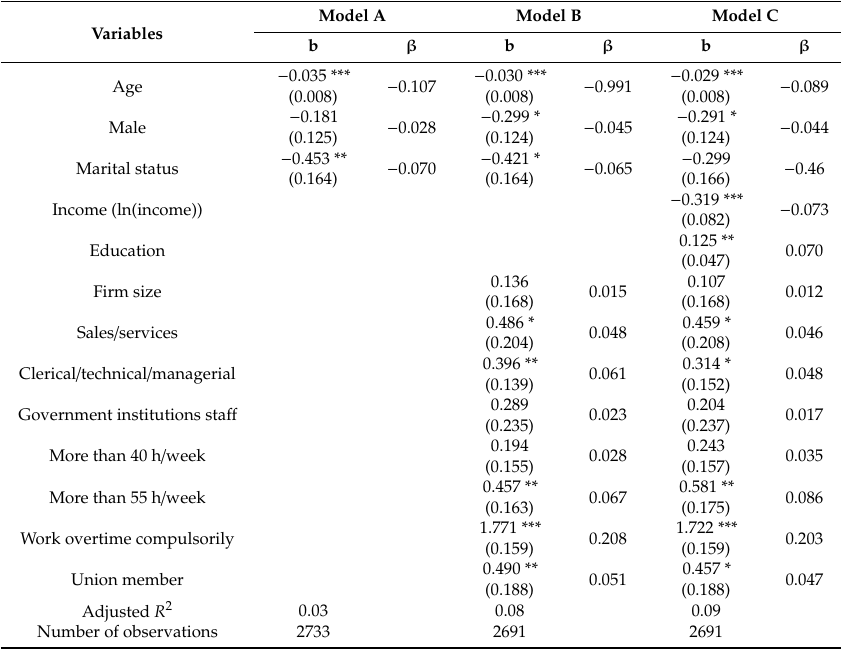
Table 3. Association between objective work-related factors and depression.